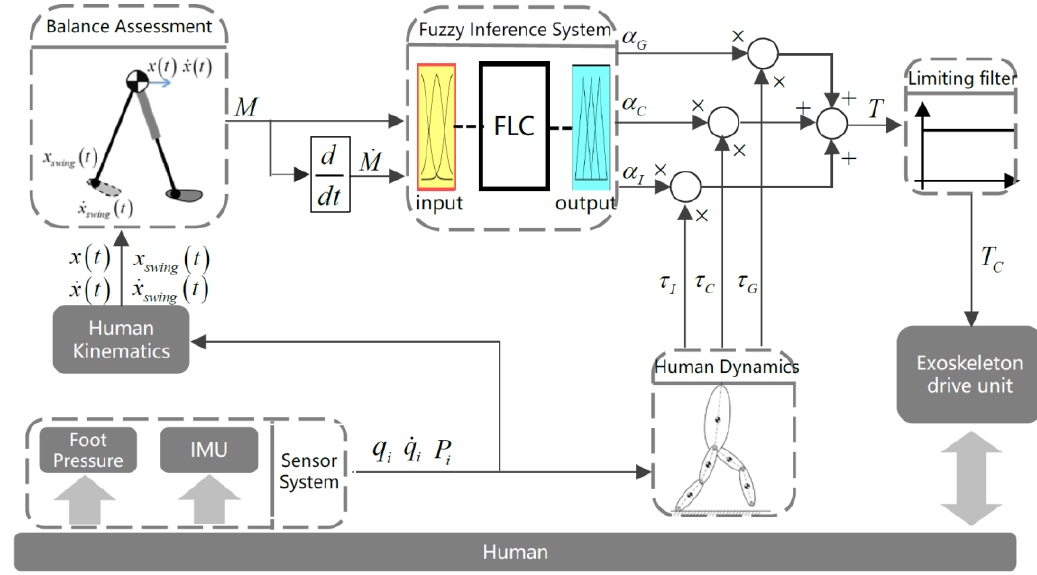
Figure 8. The balance assistance control framework.